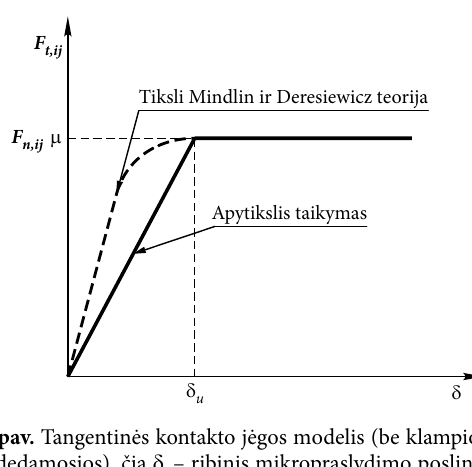
Fig. 2. Viscous force and Hertz contact stress – an overlap model for a deformation path 1–5: 1–2 – decisive effect depends on the tractive force of a viscous contact; 2–3 – decisive effect depends on Hertz contact stress; 3–4 – decisive effect depends on the repulsion force of a viscous contact; 4–5 – decisive effect depends on the repulsive force of Hertz contact (at a later stage, the particle can lose a contact due to repulsive force)